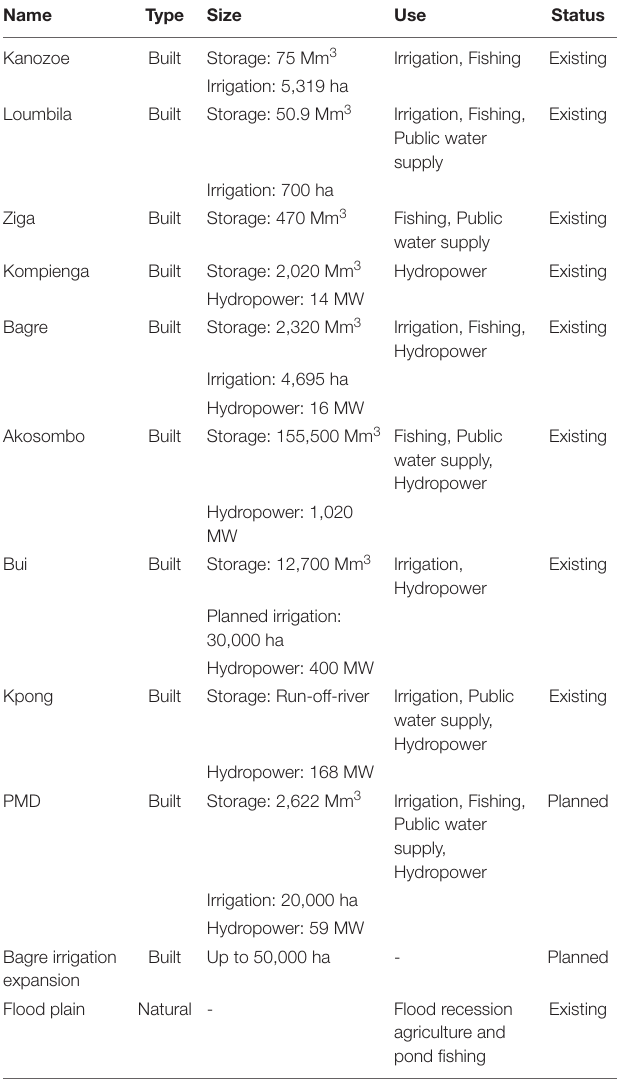
TABLE 1 | Summary of the existing and future built and natural